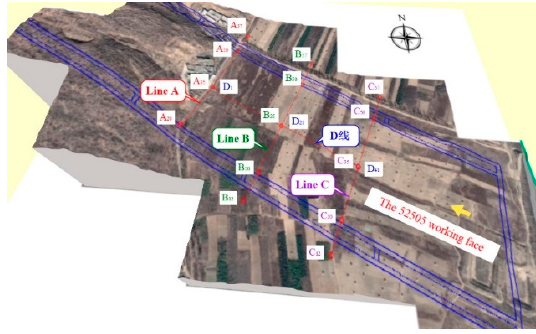
Figure 5. Surface topography and measuring points’ layout of the 52,505 working face.